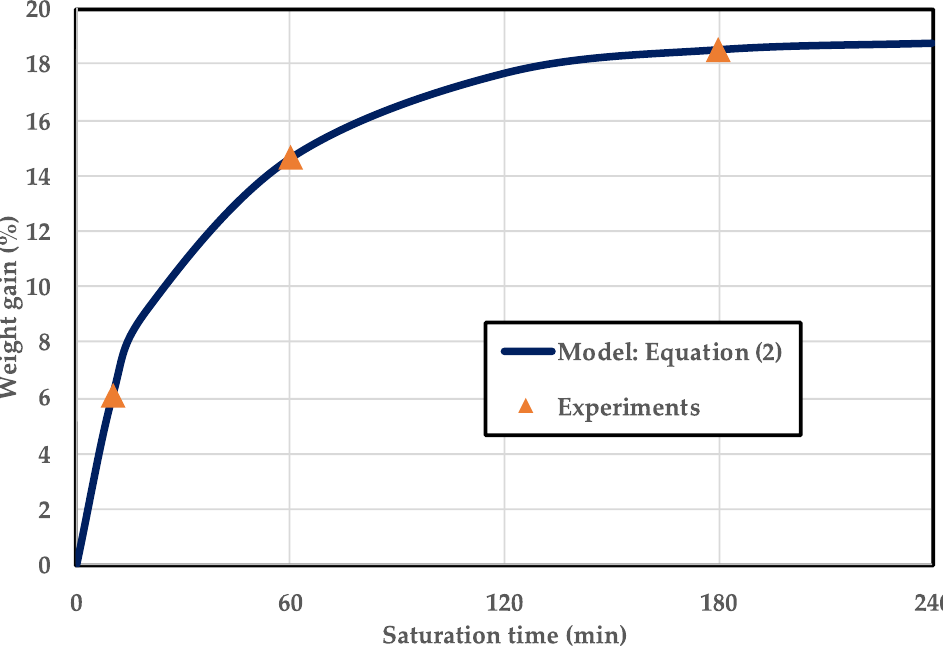
Figure 6. Gas adsorption curve as a function of saturation time at 5 MPa and 24 °C in PMMA.